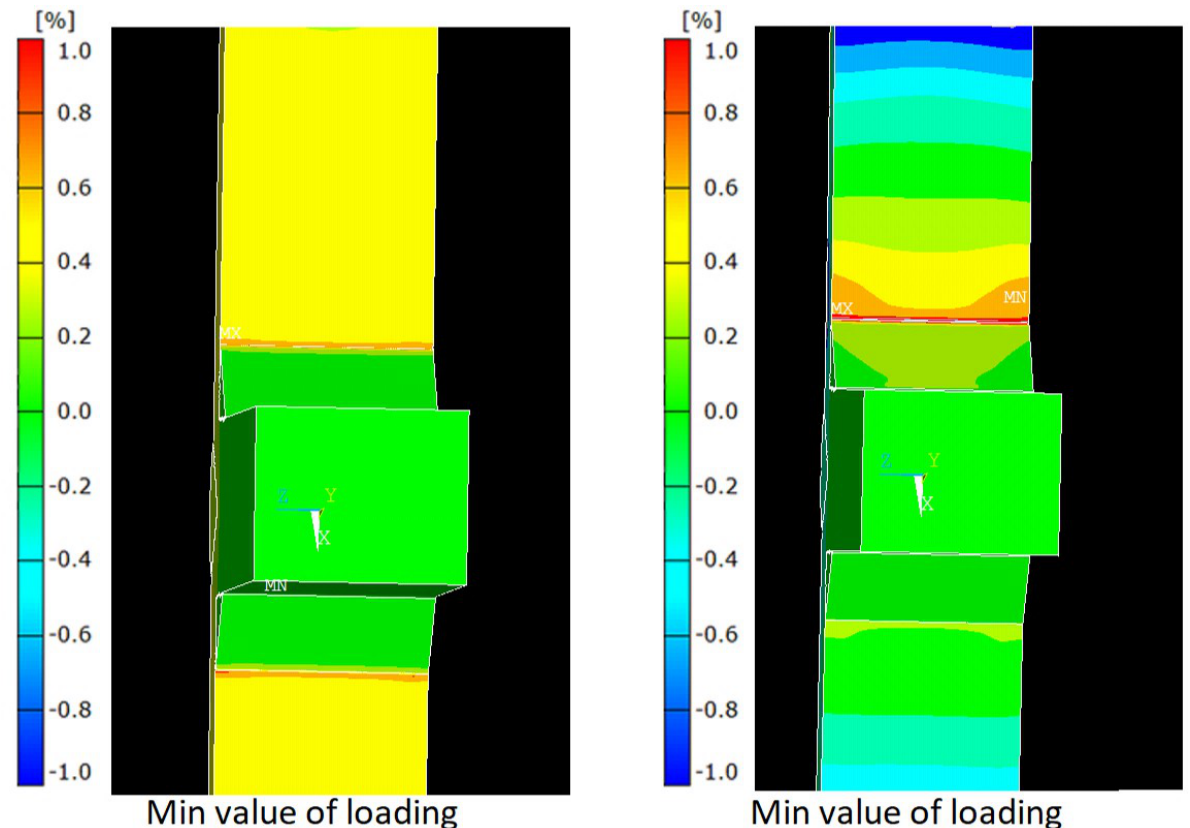
Figure 6. Longitudinal strain maps by means of FEA. (( Left ) max value of loading; ( Right ) min value of